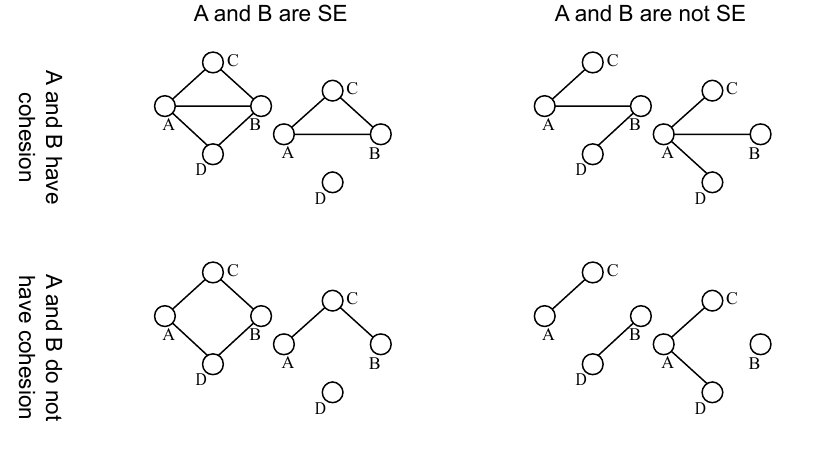
Figure 1. Cohesion and structural equivalence